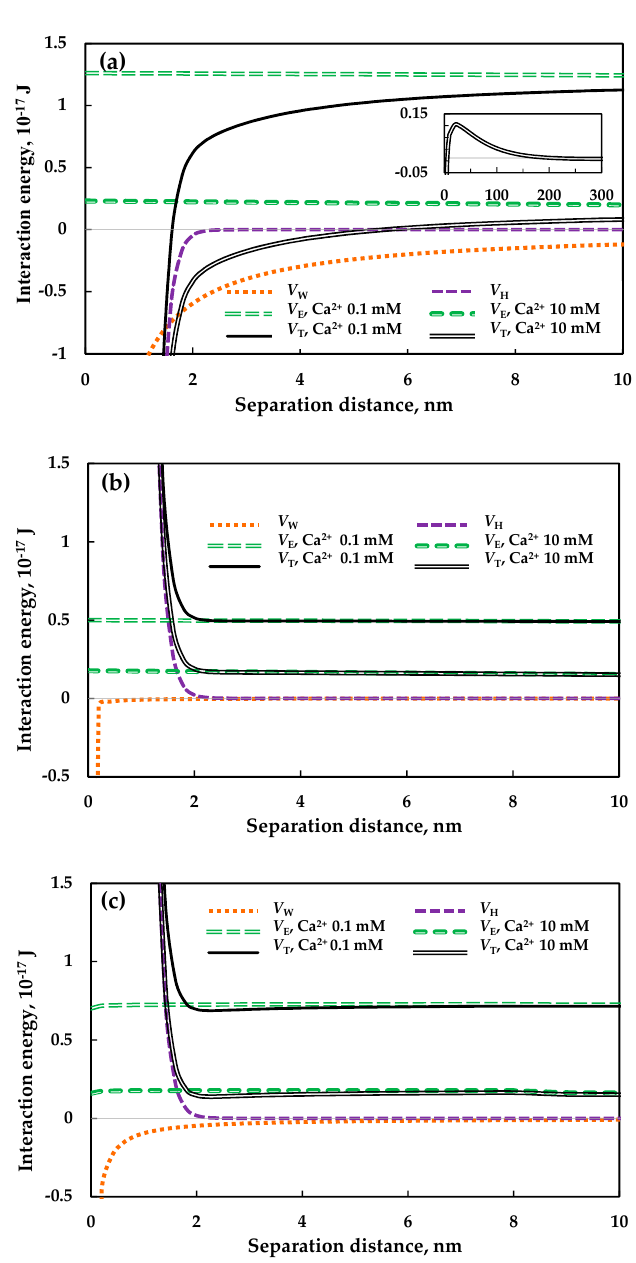
Figure 1. Predicted potential energy between particles with different calcium ion concentrations (coagulant) by XDLVO: ( a ) coal-coal; ( b ) illite-illite and ( c ) coal-illite. The absence of “Ca 2+ ” in the legend means that no coagulant was added.